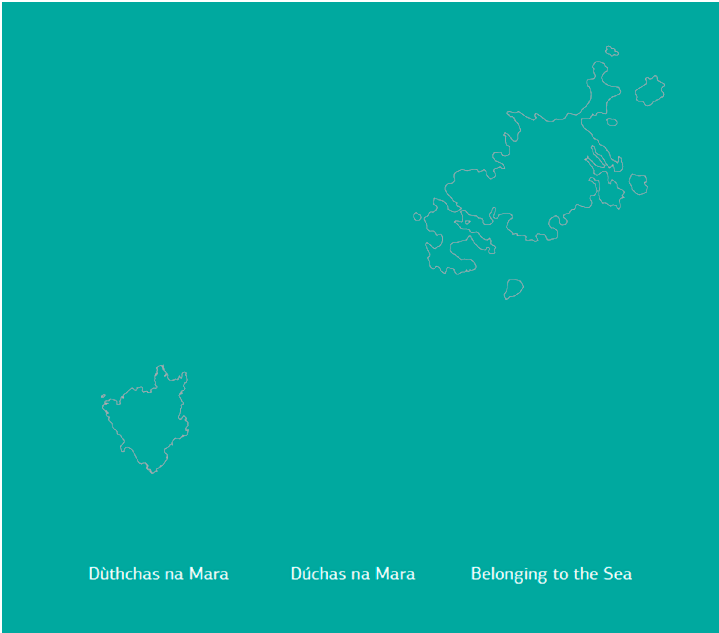
Figure 8. Belonging to the Sea (2012) cover map by Stephen Hurrel. e-book. Image used with permission form the artist.